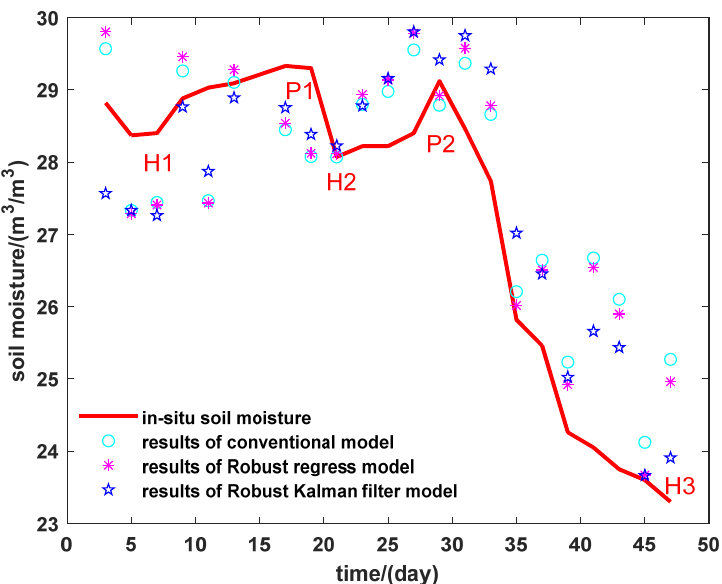
Figure 5. Estimation results of methods by using amplitude on L2 (PRN1), we highlighted for validation data the main moisture peaks (P1 day 17; P2 day 29) and holes (H1 day 6; H2 day 20; and H3 day 47). We can note that the difference between H1 and P1 is less than 1*10 − 2 m 3 /m 3